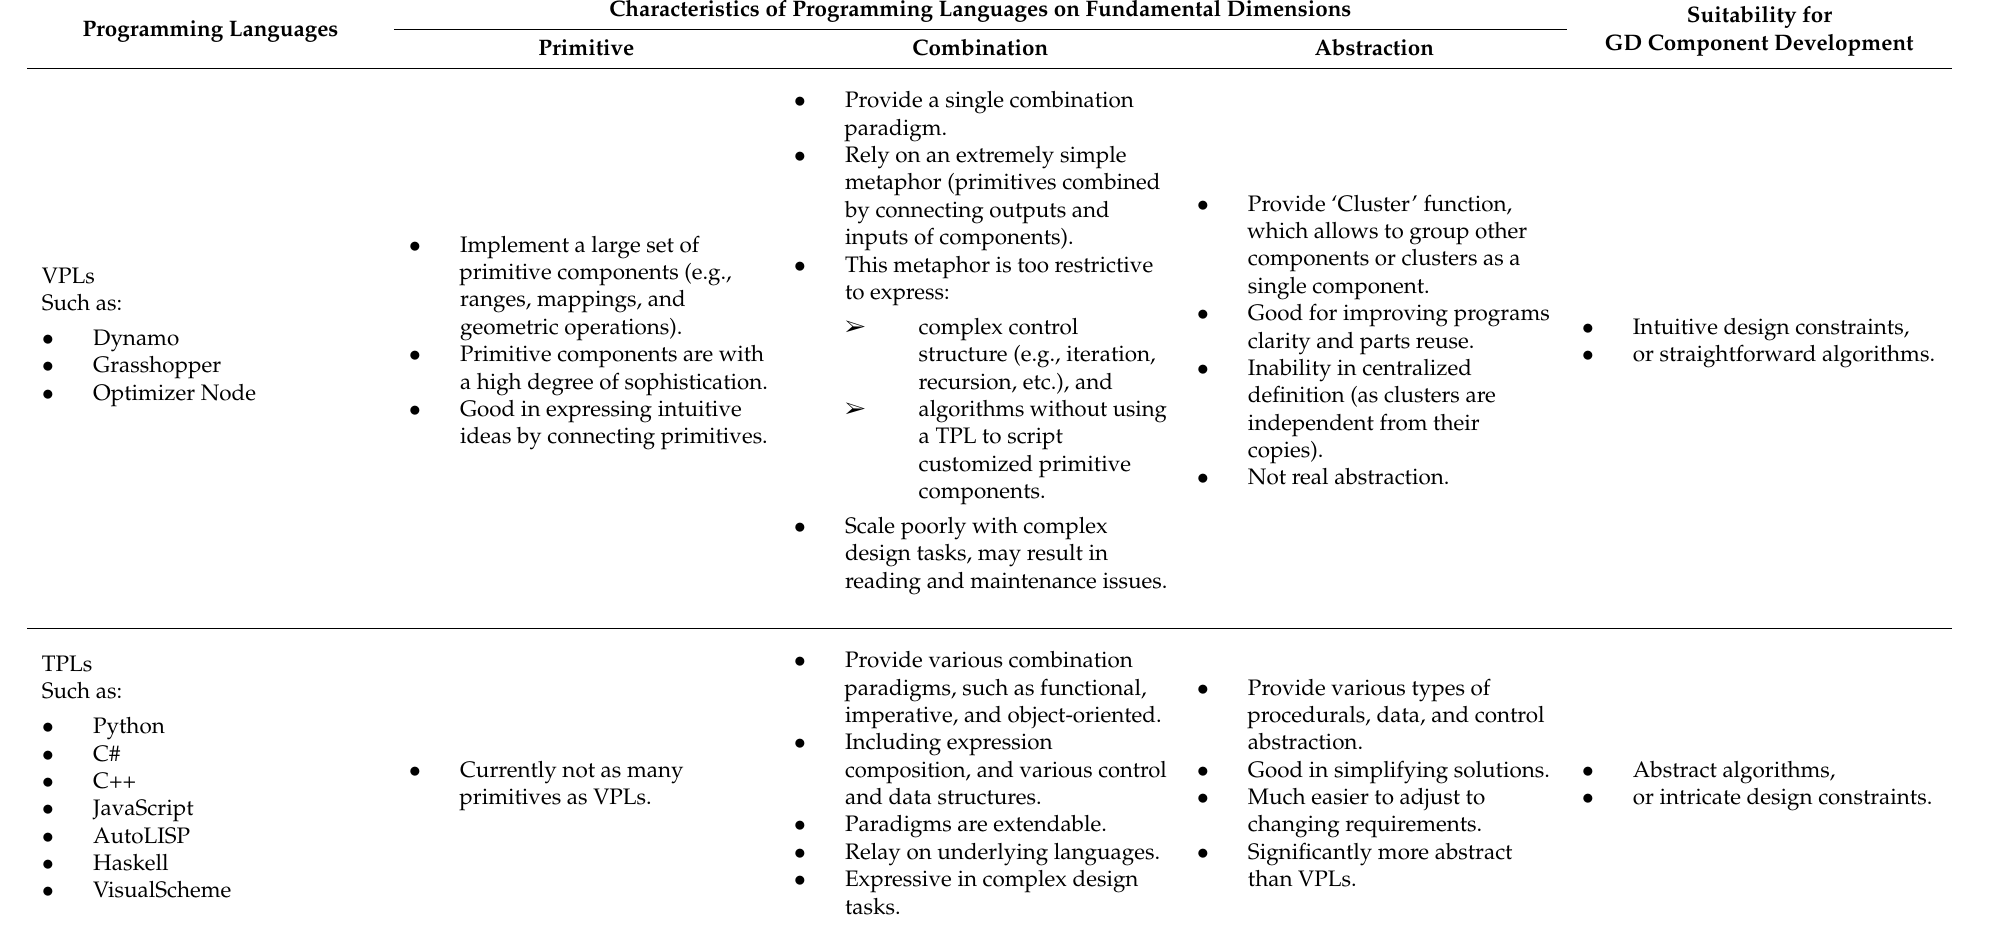
Table 5. Suitability relationship between programming languages and GD components